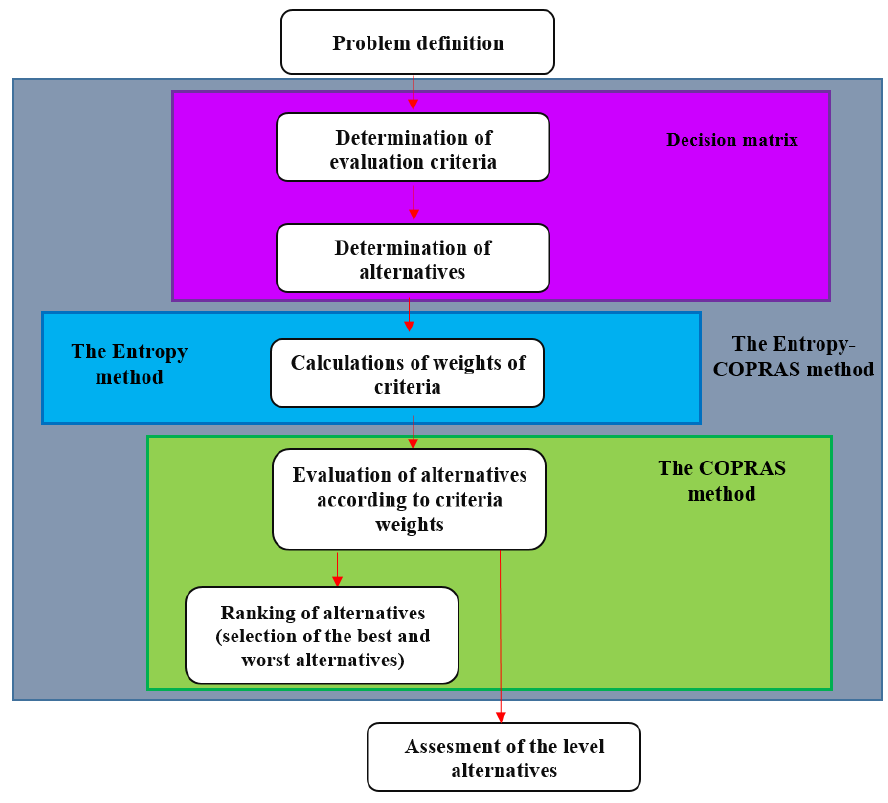
Figure 1. Procedure scheme using the entropy–complex-proportional-assessment (COPRAS) method.